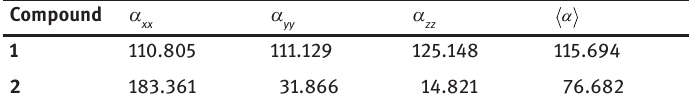
Table 1: Some selected components of the static )0;0( a and )0;0( a ( × 10 -24 esu) values for 1 - 2 .